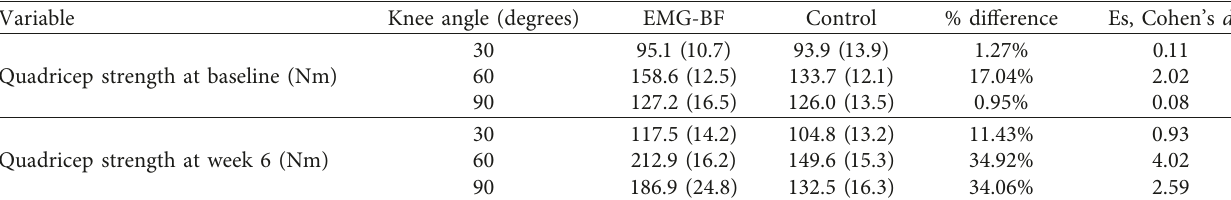
Table 4: Summary of effect sizes (ES) between two